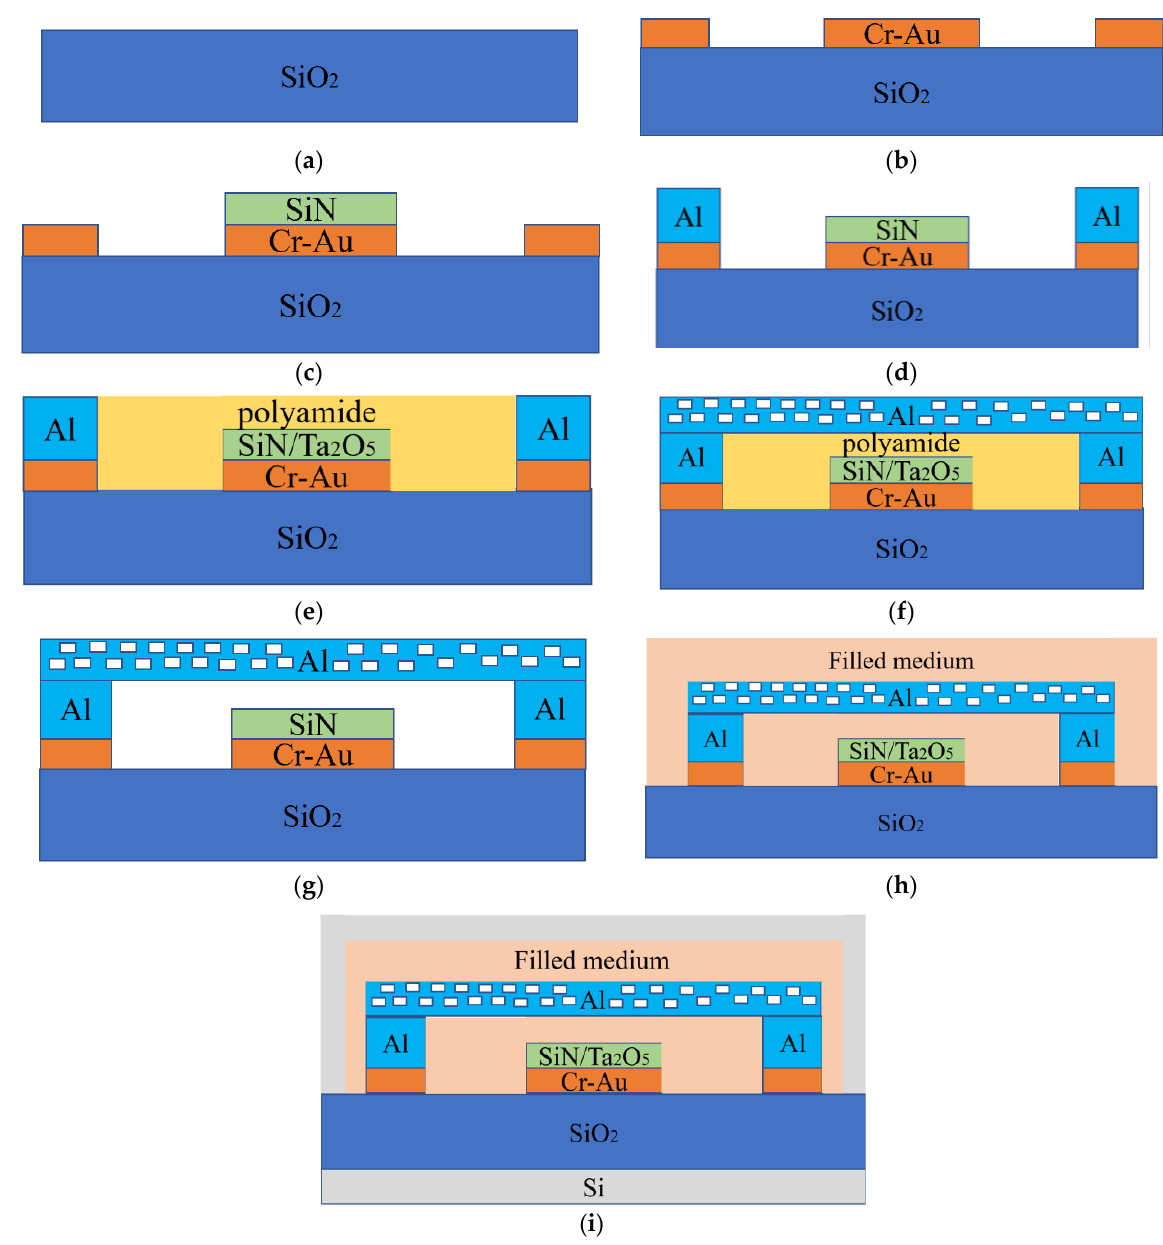
Figure 4. RF MEMS switch preparation process.